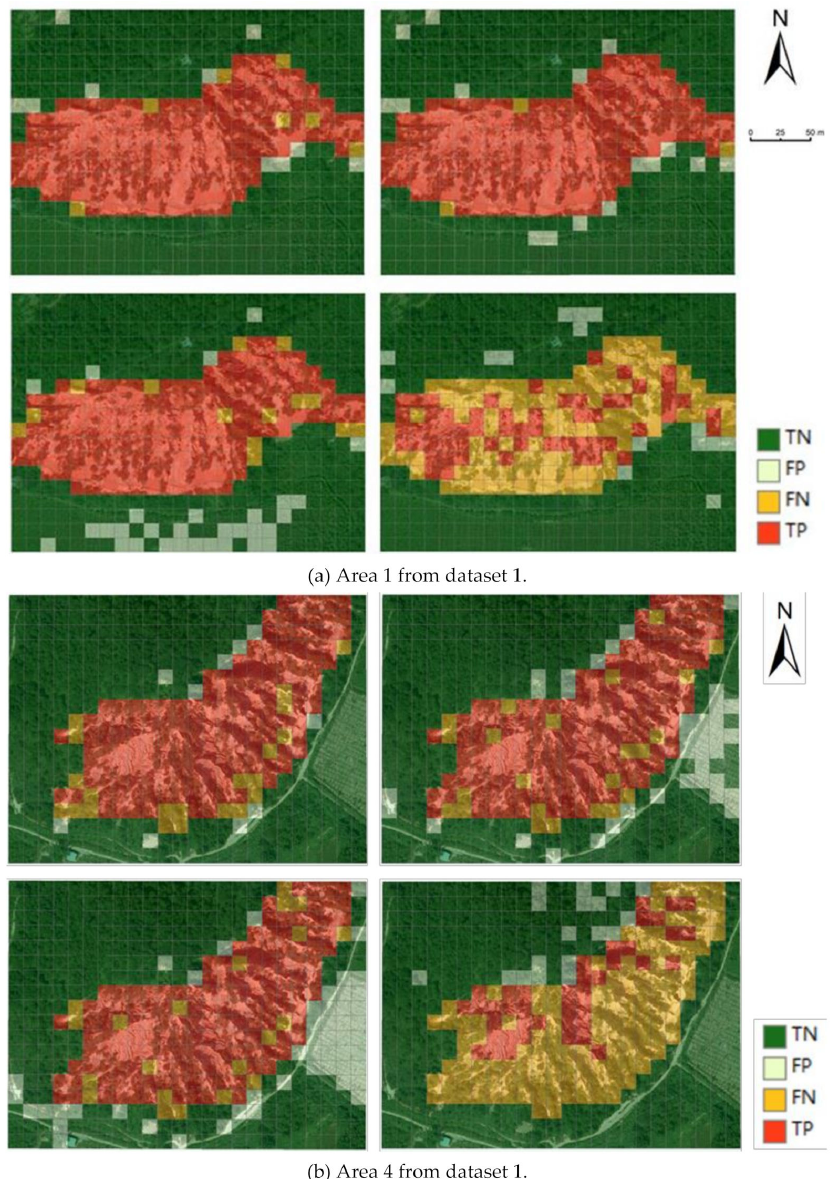
Figure 6. Comparison of detection results for two benggang areas. ( Top left ) The proposed approach. ( Top right ) Concat-Fusion. ( Bottom left ) VGG-DOM. ( Bottom right ) DCNN-DSM. TP: true positive (benggang cells are correctly detected); FP: false positive (non-benggang cells are incorrectly classified as benggang); TN: true negative (non-benggang cells correctly classified as non-nenggang); and FN: false negative (benggang cells incorrectly classified as